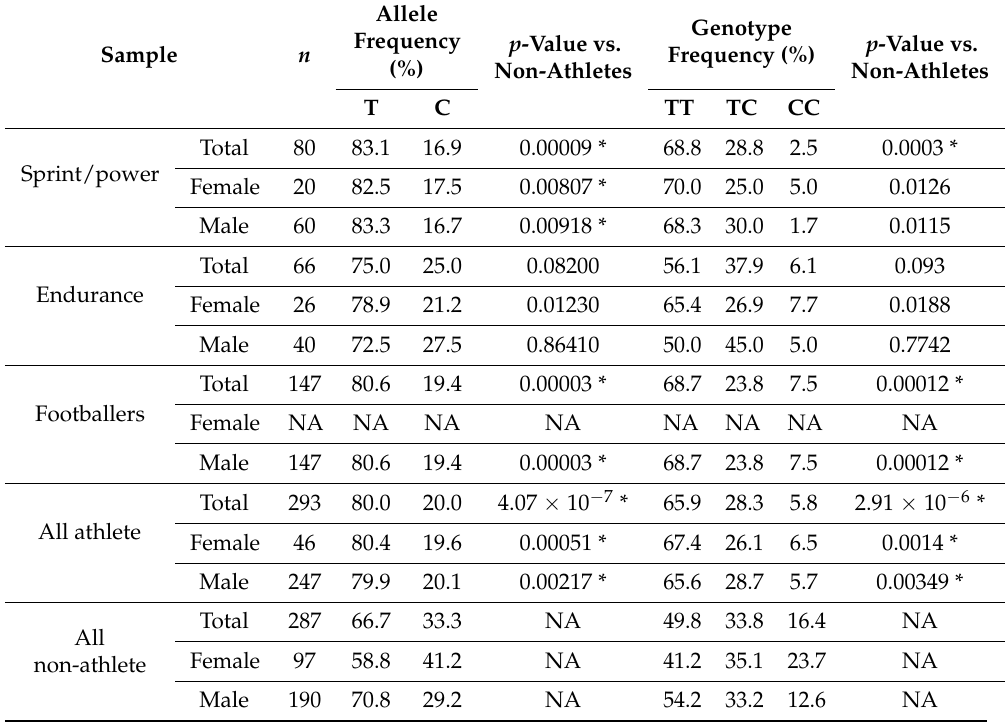
Table 1. Genotype and allele frequencies of the COL12A1 rs970547 polymorphism in athletes and non-athletes from Lithuania. Sample n